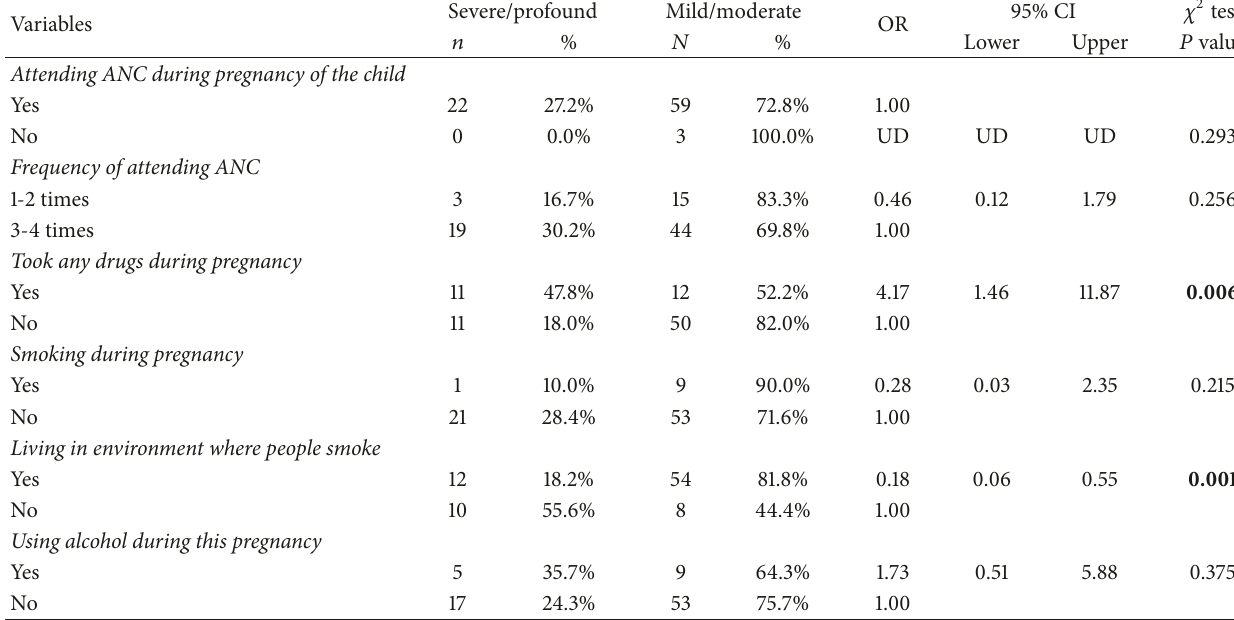
Table 5: Relationship between pregnancy-related factors and severity of intellectual